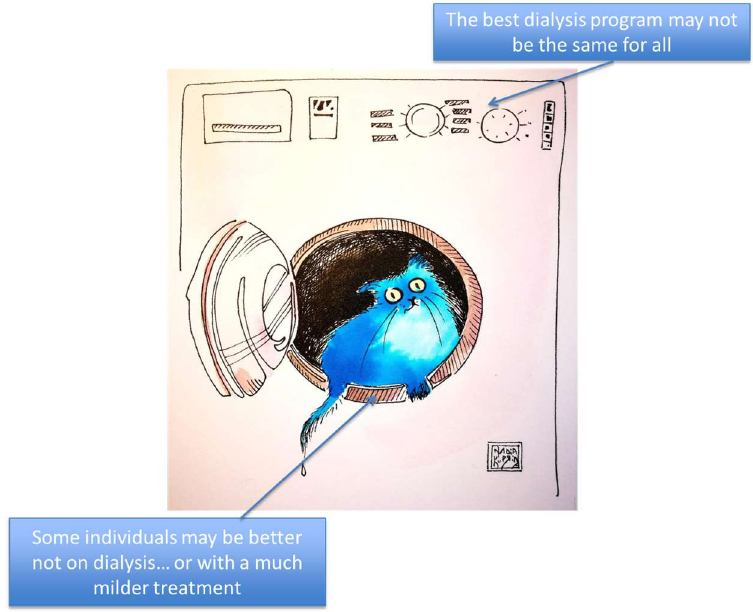
Figure 4. Different programs for the “washing machine”: choosing the “program” does not only regard tailoring treatments, but also the decision of whether or not to start renal replacement therapy.